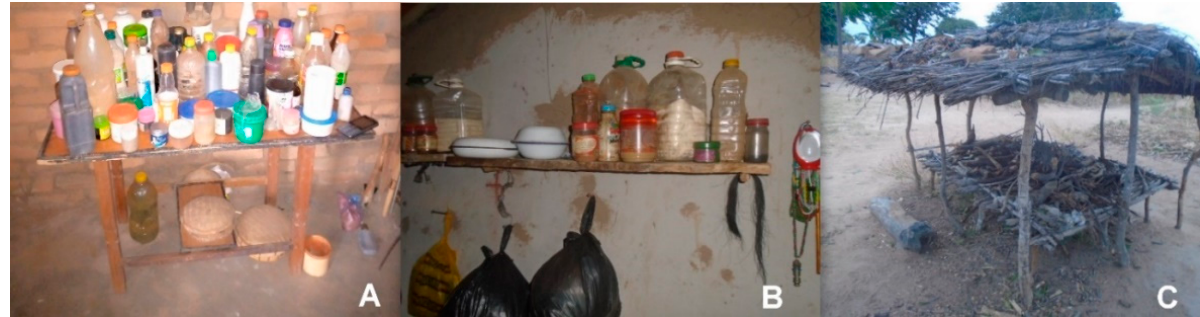
Figure 6. ( A , B ) Storage of processed plant materials in bottles and plastic bags; ( C ) storage of unprocessed plant materials under a